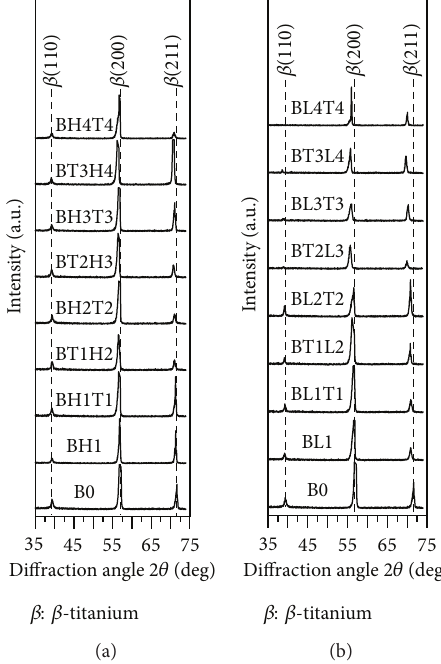
Figure 7: XRD patterns for specimens after successive (a) AH j T l and (b) AL j T l treatments.